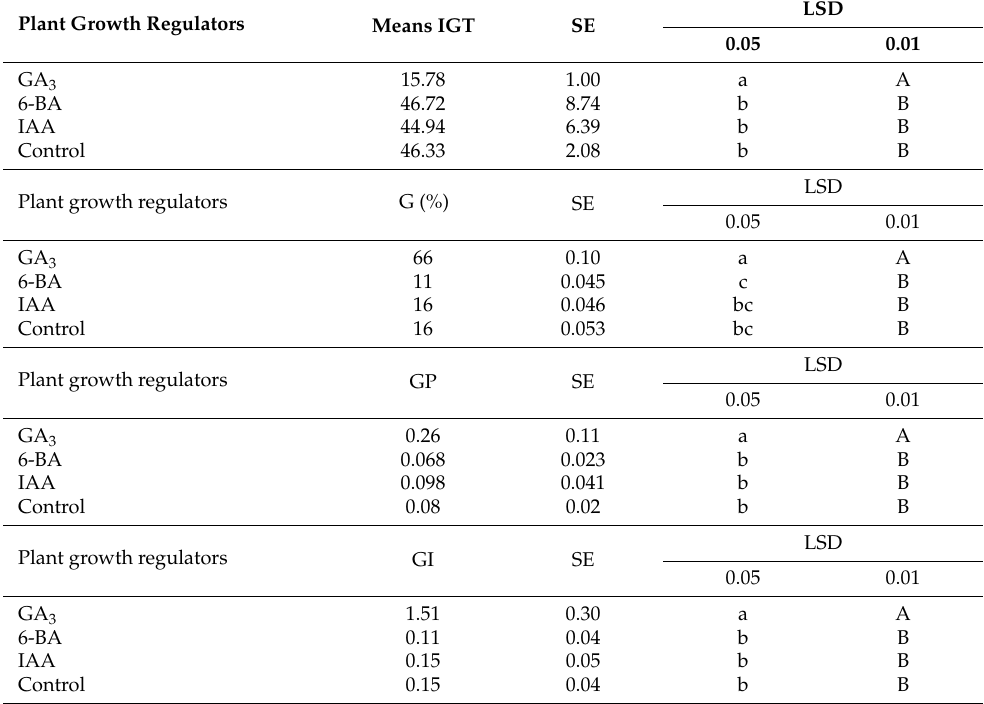
Table 3. Multiple comparisons of effects of GA 3 , 6-BA and IAA treatment on initial germination time (IGT), germination percentage (G), germination power (GP), and germination index (GI). SE is standard error and LSD is Fisher’s Least Significant Difference at P ≤ 0.05 and 0.01. Plant Growth Regulators Means